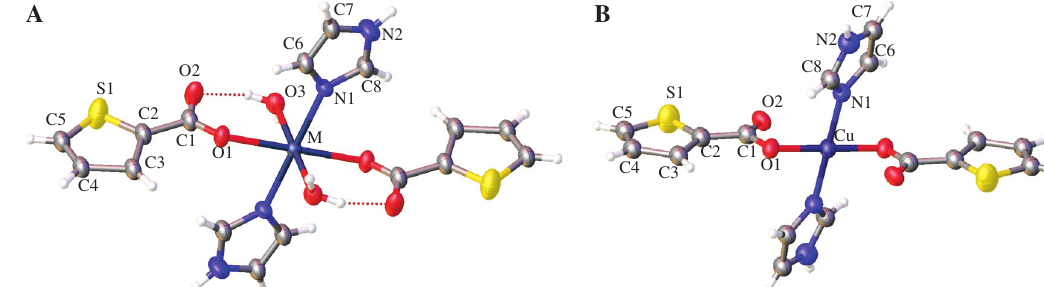
Figure 1 The structures of the complexes. (M = Mn, Co or Cd).